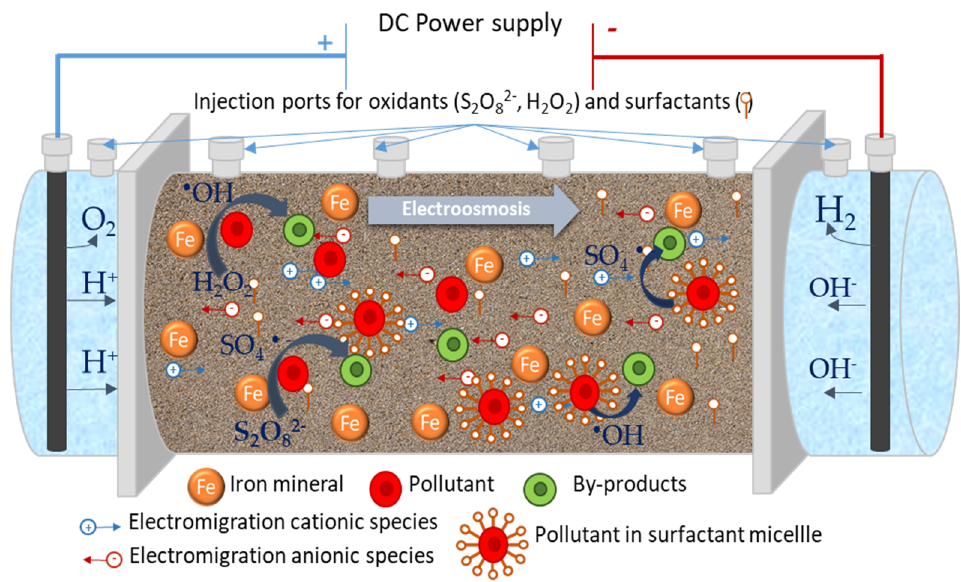
Figure 5. Schematic of the EK–Fenton process.